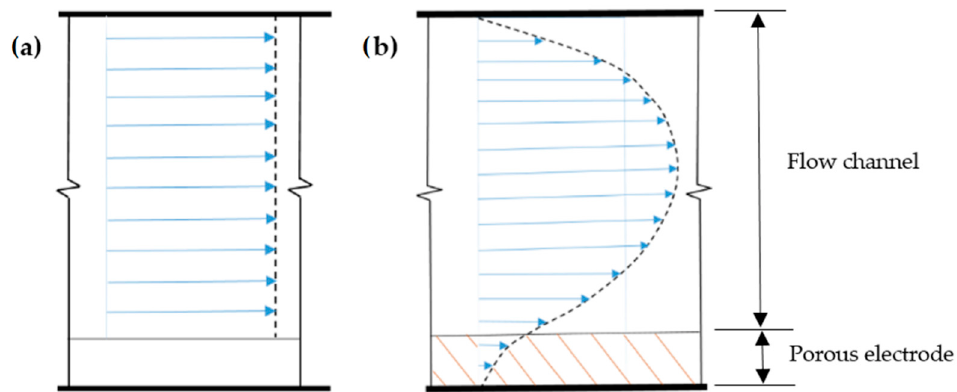
Figure 8. Electrolyte flow distribution: ( a ) Flow field distribution at the entrance of the flow channel; ( b ) an intermediate point, where the flow penetrates into the porous electrode. Redrawn from [32].